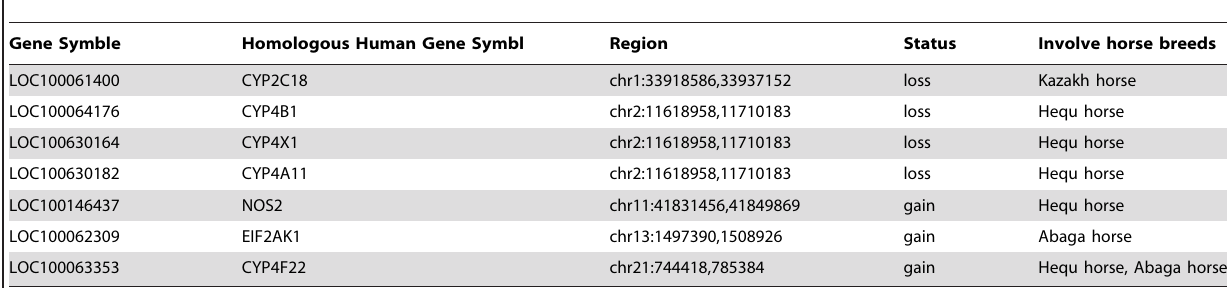
Table 4. The information of 7 genes.